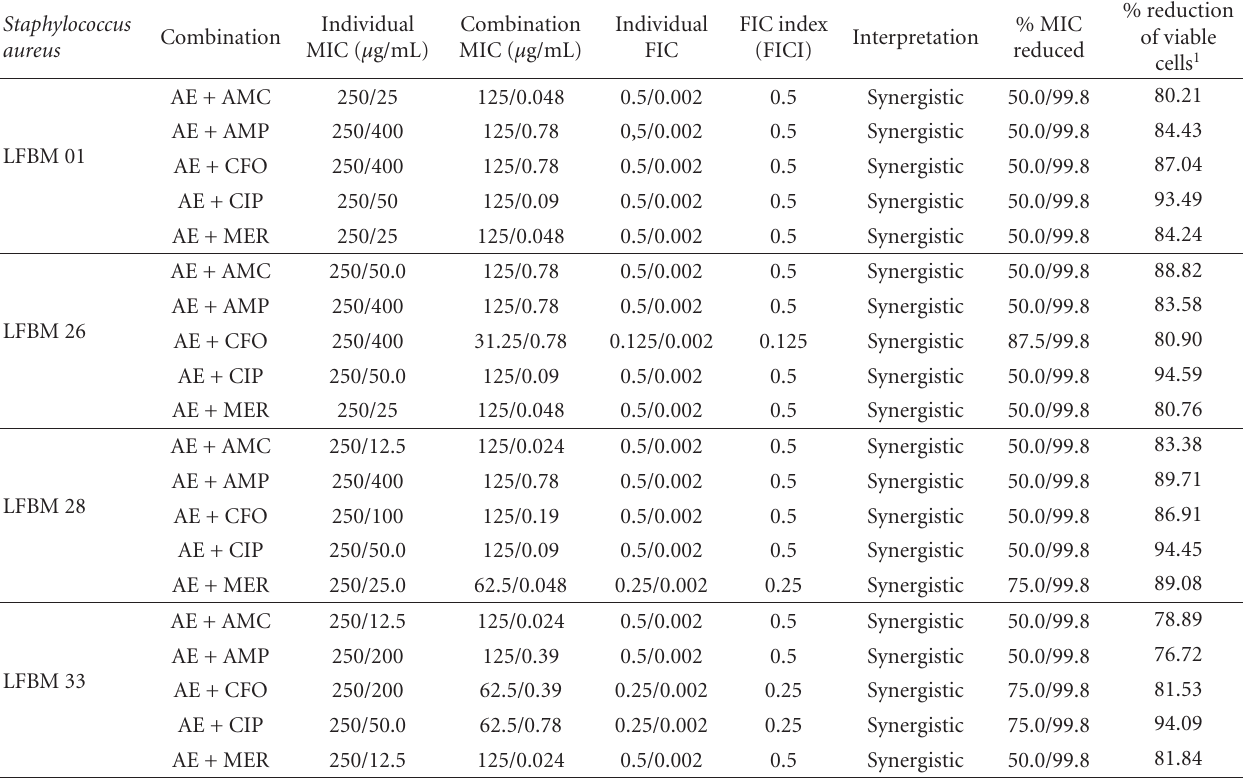
Table 2: Combination testing of the aqueous extract of Psidium guineense with antimicrobial agents against MRSA strains. Staphylococcus aureus